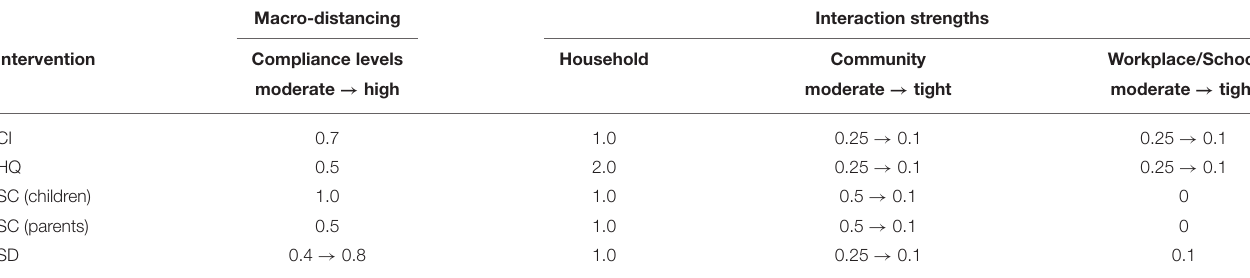
TABLE 1 | The macro-distancing parameters and interaction strengths: retrodiction (“moderate”) and counter-factual (“tight.”). Macro-distancing Interaction strengths Intervention Compliance levels Household Community Workplace/School moderate → high moderate → tight moderate → tight